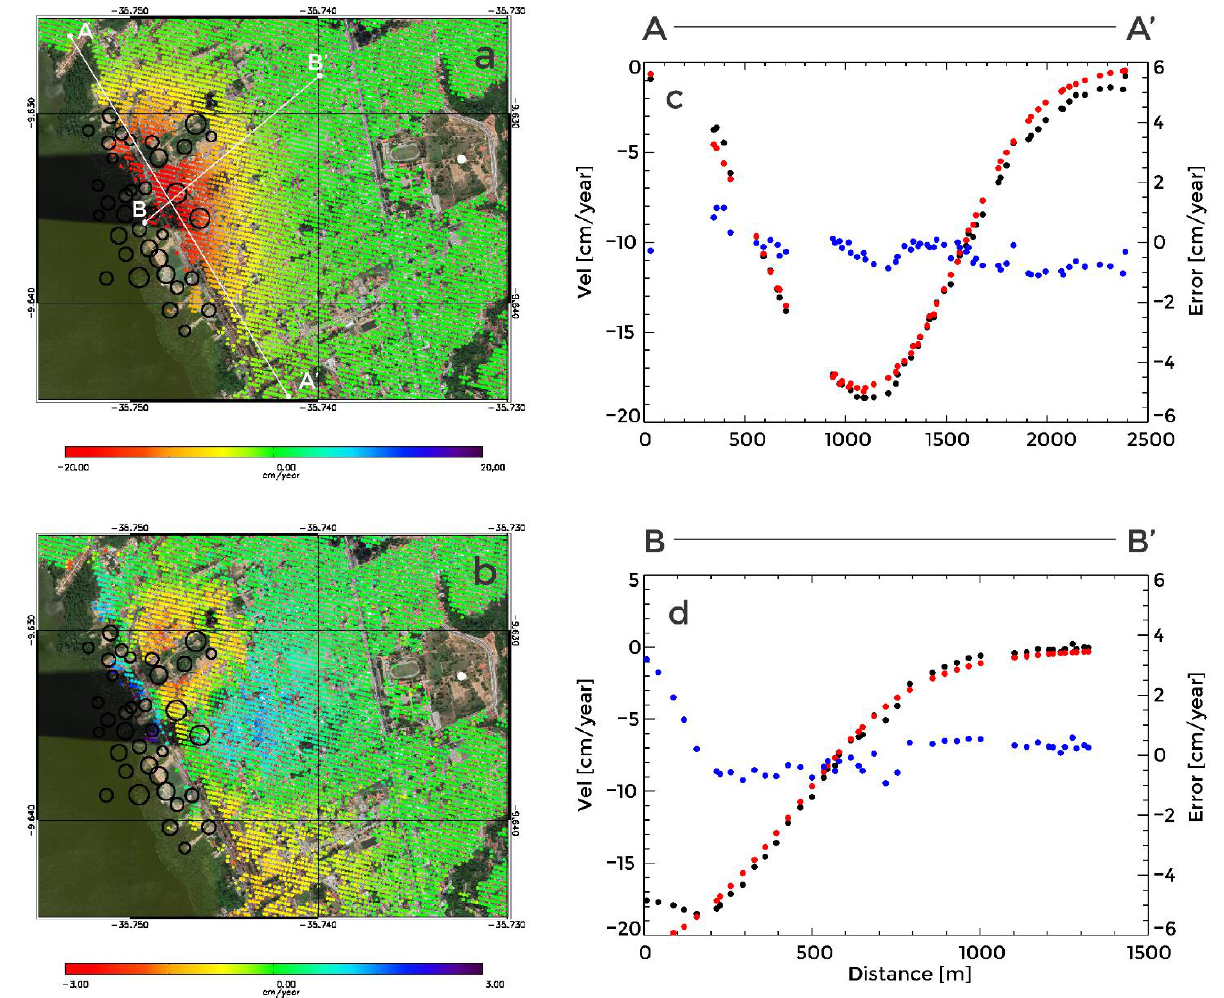
Figure 3. a) Deformation produced by a sill-like source characterized by the parameters of Table 1. b) Residuals between the modelled and measured deformation. c,d) profiles AA’ and BB’, respectively, of the modelled (red dots) and measured (black dots) deformation. Residuals are represented by the blue dots.